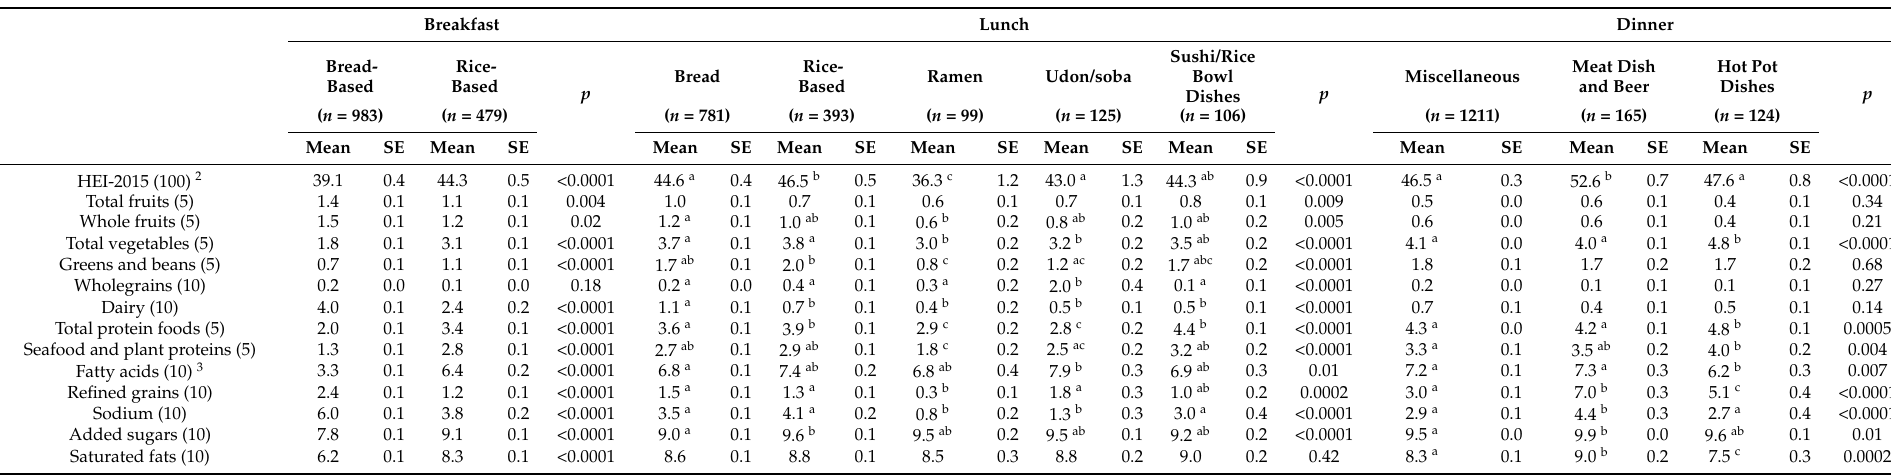
Table 4. Comparison of diet quality scores among dish-based dietary patterns for each meal 1